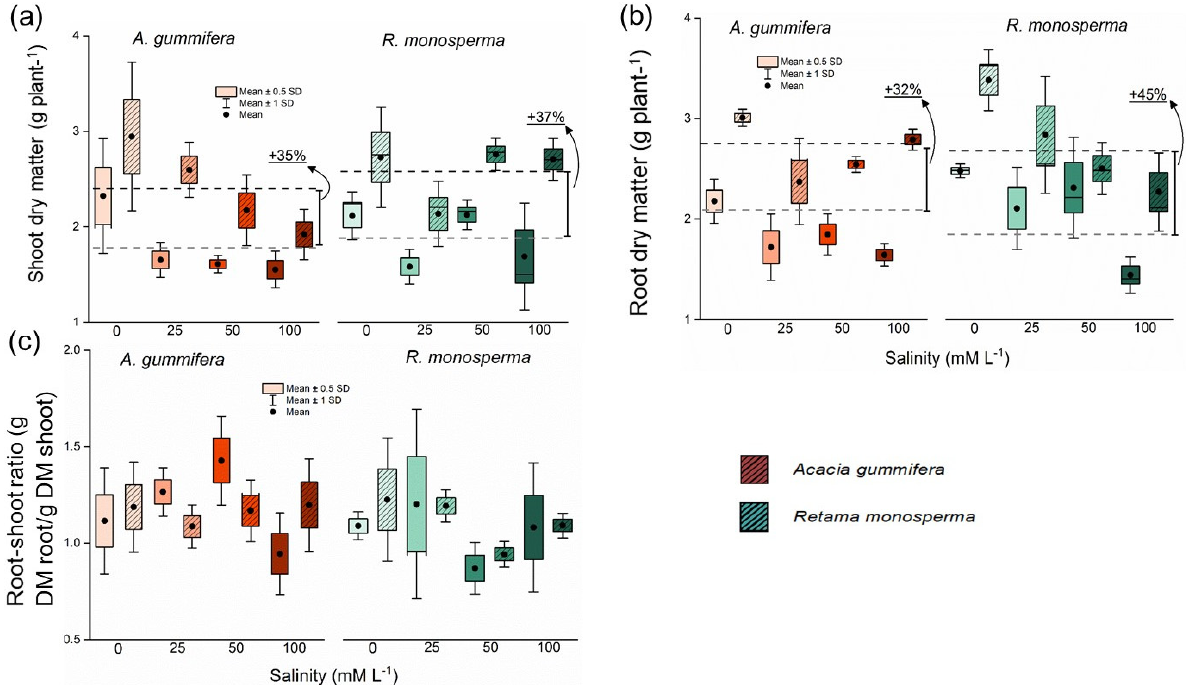
Figure 2. Boxplots of shoot ( a ), root ( b ) dry matter, and root-to shoot ratio ( c ) of the non-inoculated and inoculated Acacia gummifera and Retama monosperma plants under different salinity levels (0, 25, 50 and 100 mM NaCl). The average values of the mycorrhizal shoot and root growth responses for A. gummifera and R. monosperma species are shown by the percentage of increased value. Mycorrhizal inoculated plants are represented by dashed boxplots for both A. gummifera and R. monosperma species. At the different salinity concentration, A. gummifera species are represented by antiwhite and brown colors, and R. monosperma species are shown by tea-green, and green colors, respectively.